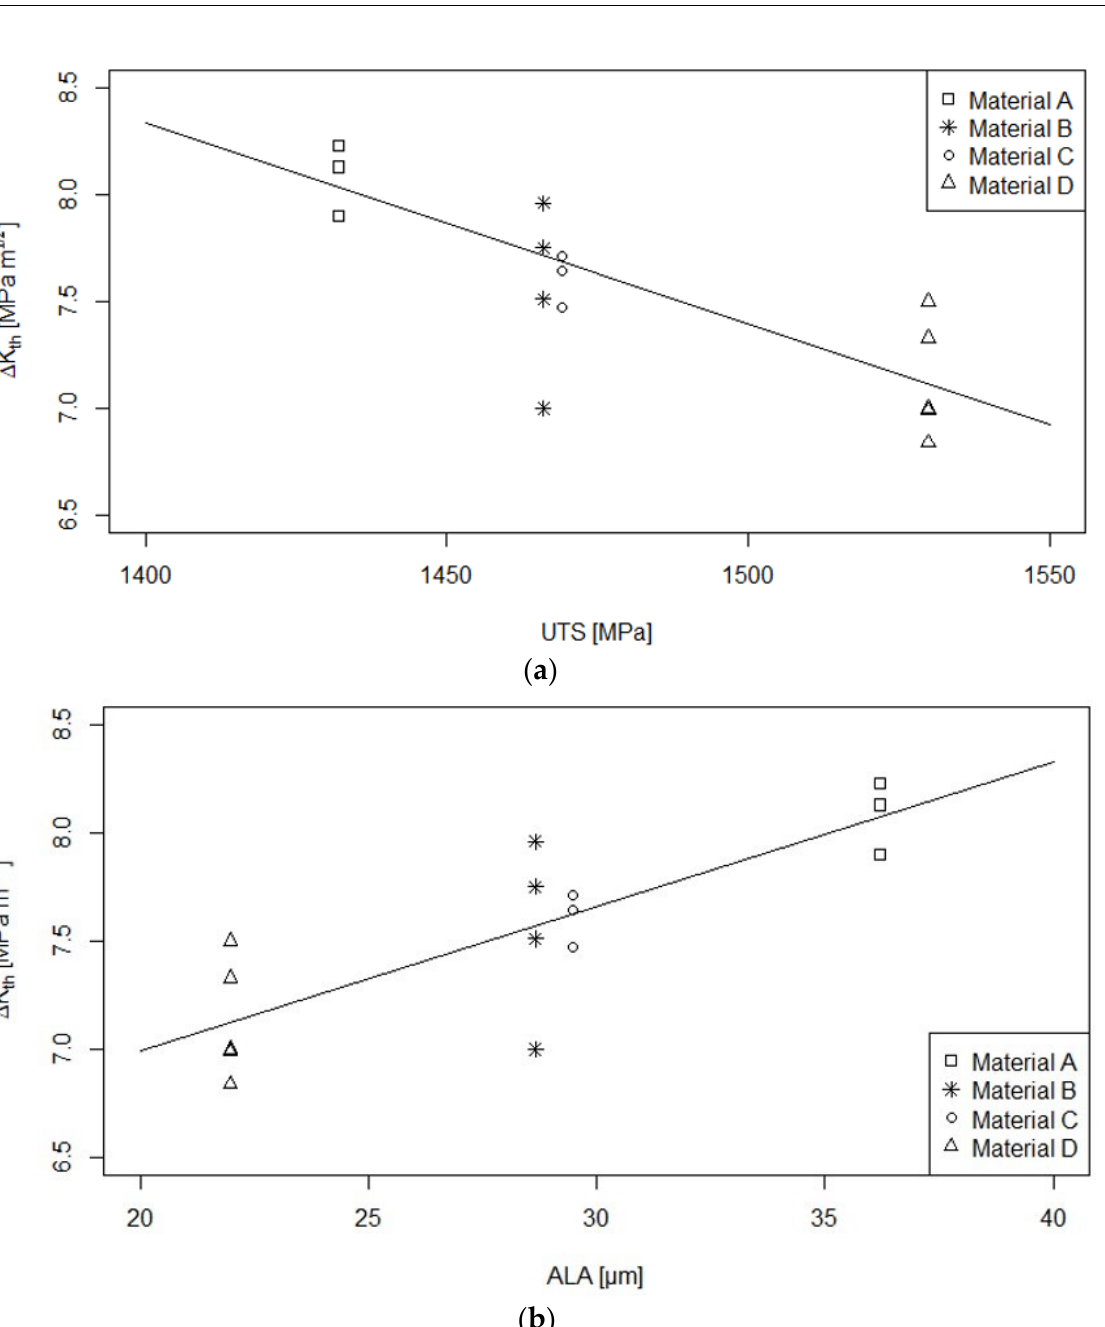
Figure 12. Linear correlation between the microstructural parameter ALA and the fracture mechan- ical parameter K IC for materials produced via the standard route; the sample from the plastically deformed Material B is marked by an asterisk and does not follow this correlation. Finally, the Paris exponent m describing fatigue crack growth kinetics does not show any significant correlation with the microstructural and mechanical properties; see Figure 13 as an example plot of m vs. ALA; however, the scatter of m decreases with increasing ALA (and ECD) and decreasing UTS, respectively.